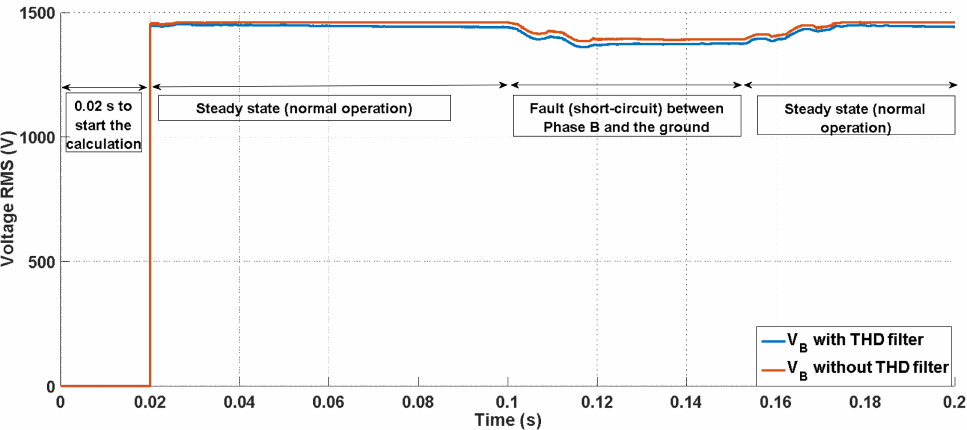
Figure 17. Compare rmsvoltage calculation using THD filter & without THD